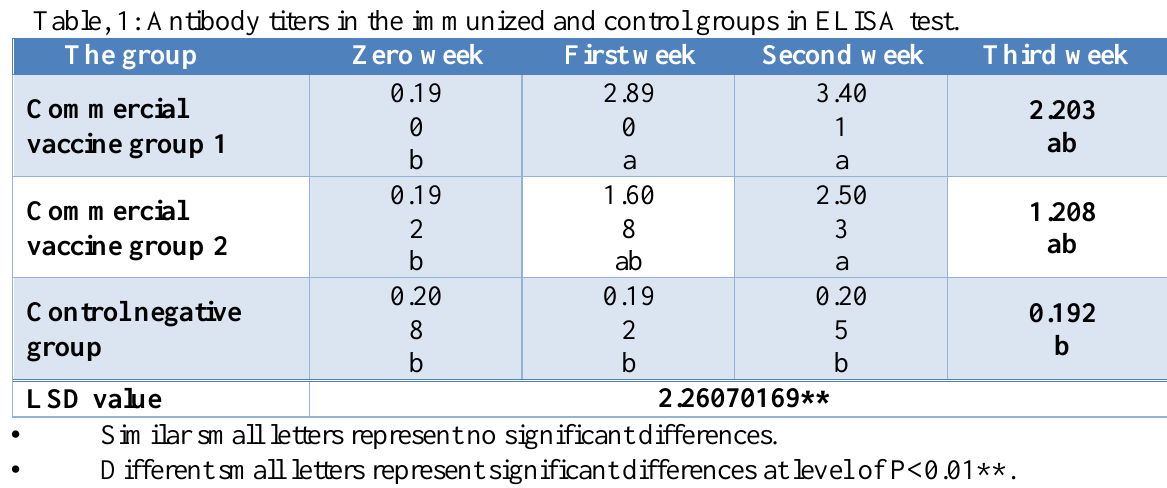
Table, 2: Re-isolation of M.haemolytica from lung after intranasal challenge. The